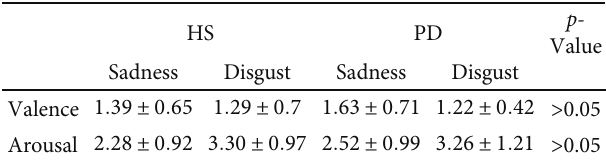
Figure 2: Corticospinal excitability of the left primary motor cortex evaluated during the observation of di ff erent types of videos in two di ff erent groups of subjects (patients with Parkinson ’ s disease, PD; healthy subjects, HS). Y -axis represents the motor evoked potentials (MEPs) amplitude (in mV). Box plots report the interquartile range and the median values. Asterisks indicate the level of signi fi cance (* p < 0 : 05 and ** p < 0 : 01 ). Table 3: Emotional valence and emotional arousal (mean ±